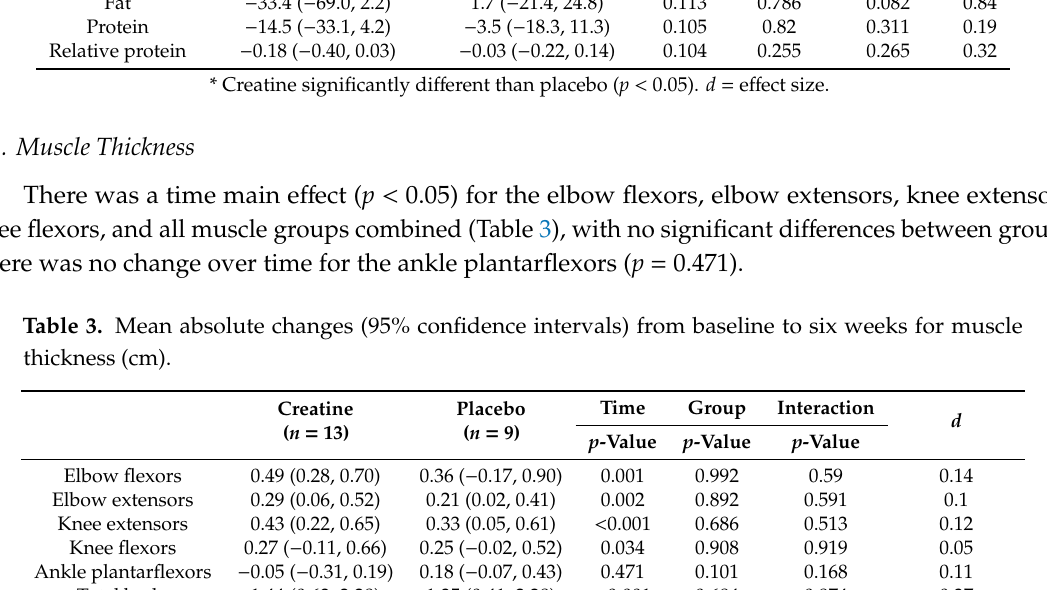
Creatine Placebo ( n = 13) ( n =